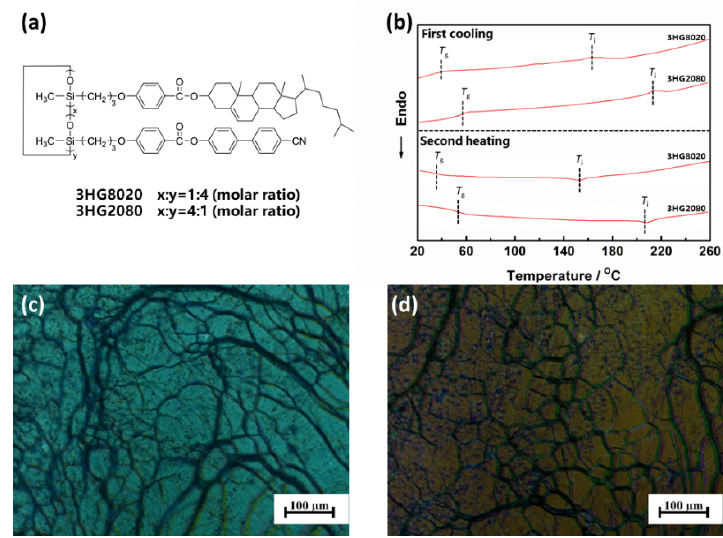
Figure 1. ( a ) The chemical structures of the side-chain liquid crystal co-polymers; ( b ) differential scanning calorimetry curves of samples 3HG8020 and 3HG2080 during the first cooling and second heating scans at a rate of 20 °C min −1 ; ( c ) polarized optical microscopic image of sample 3HG8020 at 80 °C; ( d ) polarized optical microscopic image of sample 3HG2080 at 80 °C.